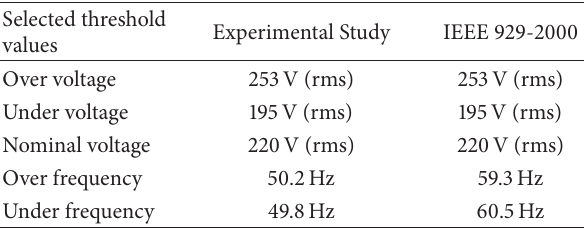
Table 3: Selected grid threshold values in experimental system. Selected